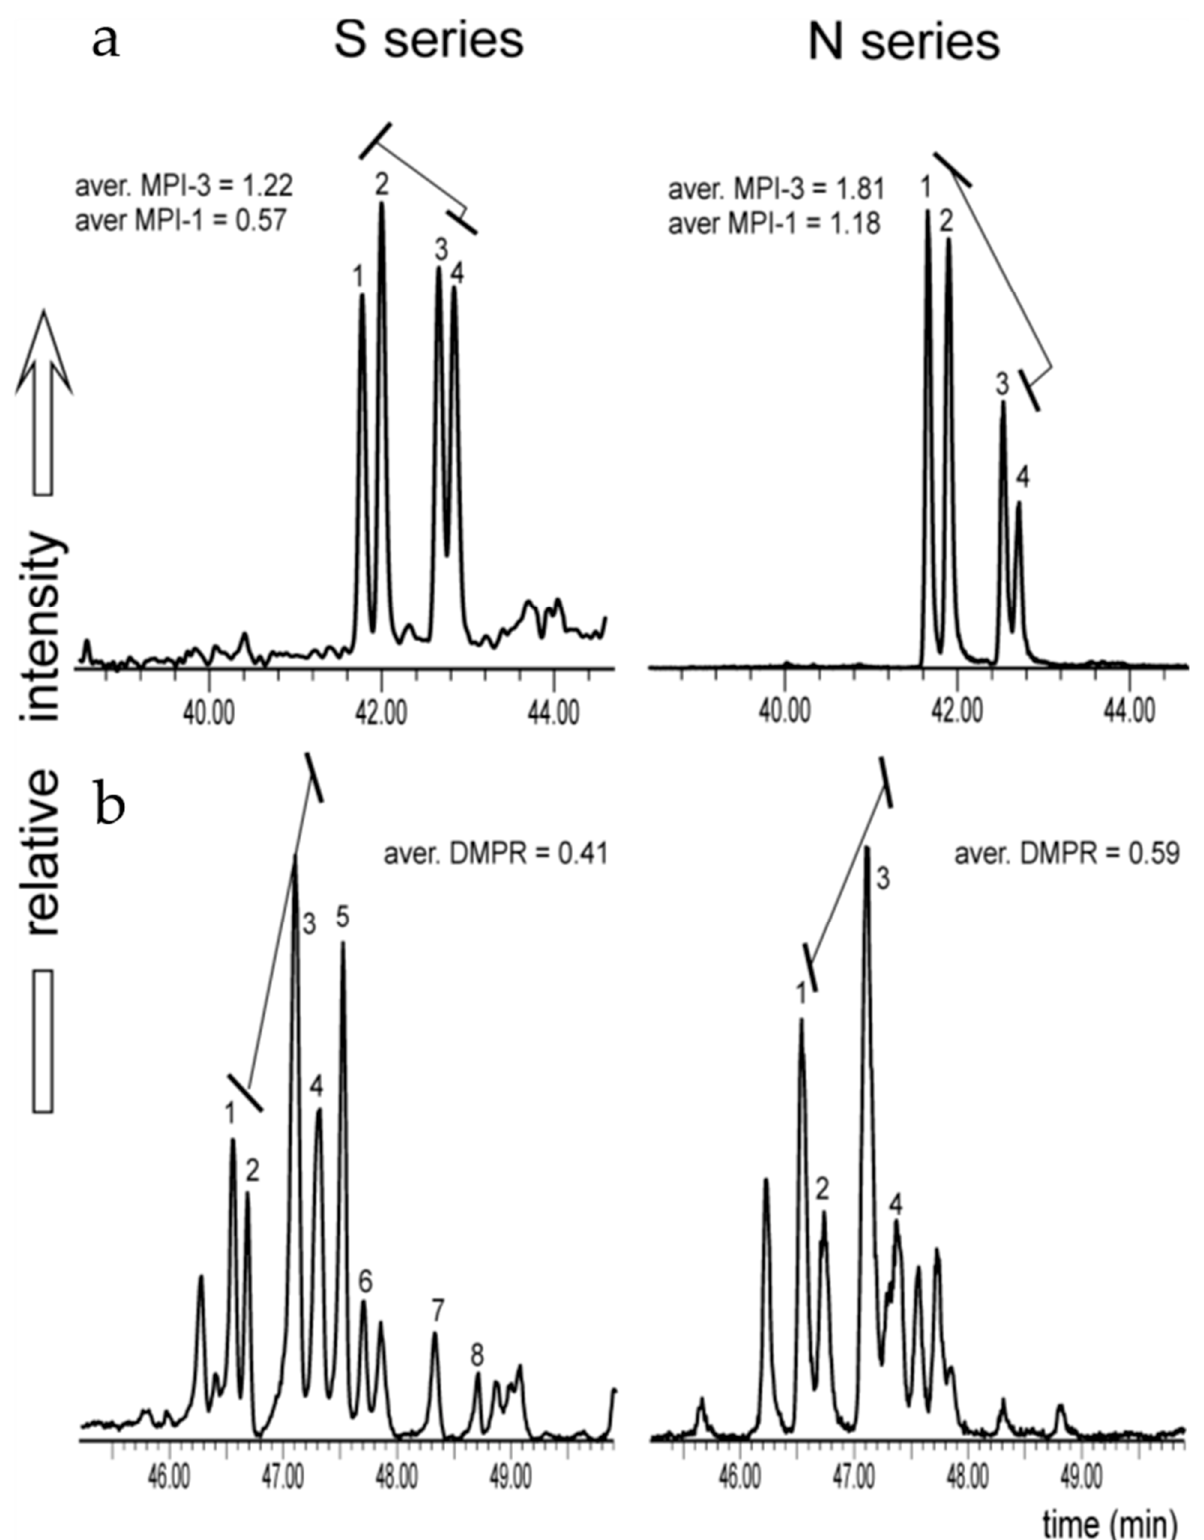
Figure 16. Distribution of alkyl phenanthrenes. ( a ) Methylphenanthrenes (MP), peaks identification: 1: 3 ‐ MP, 2: 2 ‐ MP, 3: 4 ‐ MP, and 5, 1 ‐ MP. ( b ) Dimethylphenanthrenes (DMP), peaks identification: 1, 2,6 ‐ DMP, 2, 2,7 ‐ DMP, 3, 3,10 + 1,3 + 2,10 + 3,9 ‐ DMP, 4: 1,6 + 2,9 ‐ DMP, 5: 1,7 ‐ DMP, 6: 2,3 ‐ DMP, 7: 1,9 + 4,9 ‐ DMP, and 8: 1,8 ‐ DMP.